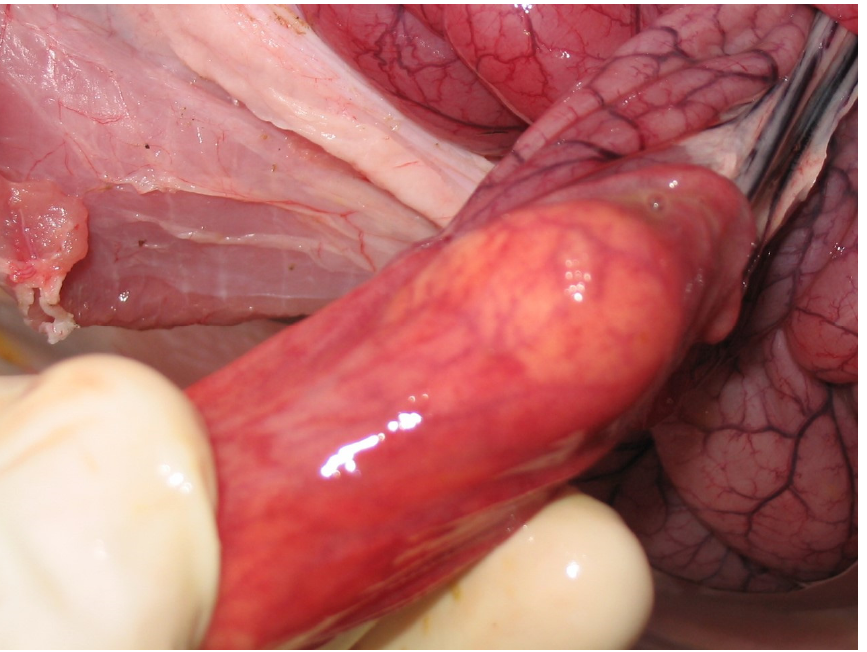
Figure 17. Extreme thinning of the small intestine of a 45 ‐ day ‐ old pig affected by